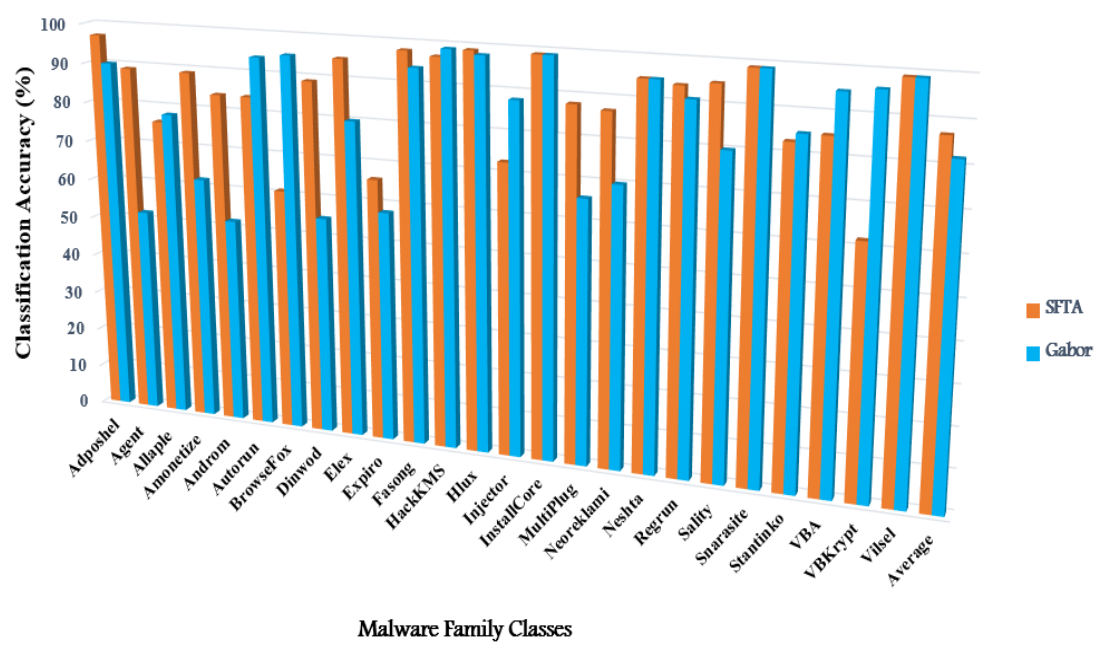
Figure 9. The classification Accuracy-based SFTA and Gabor features across NB Classifier.